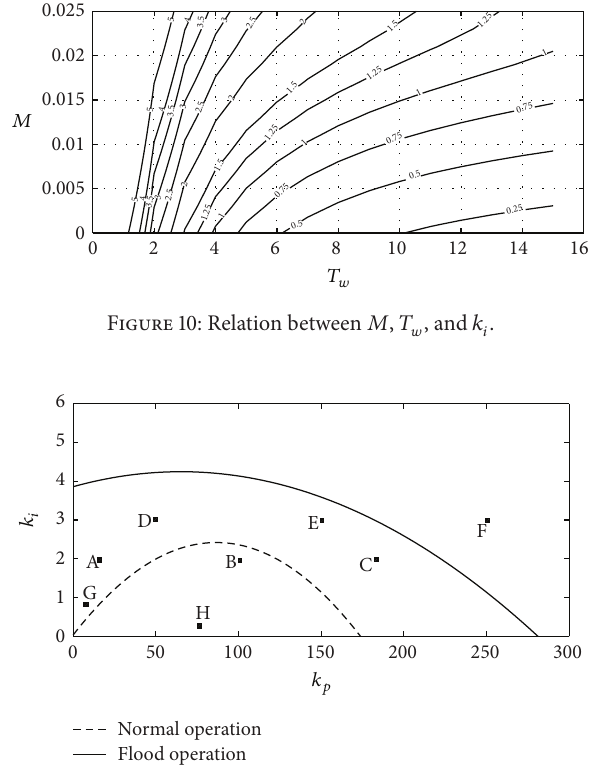
Figure 11: Stability regions in normal and flood operation condi-